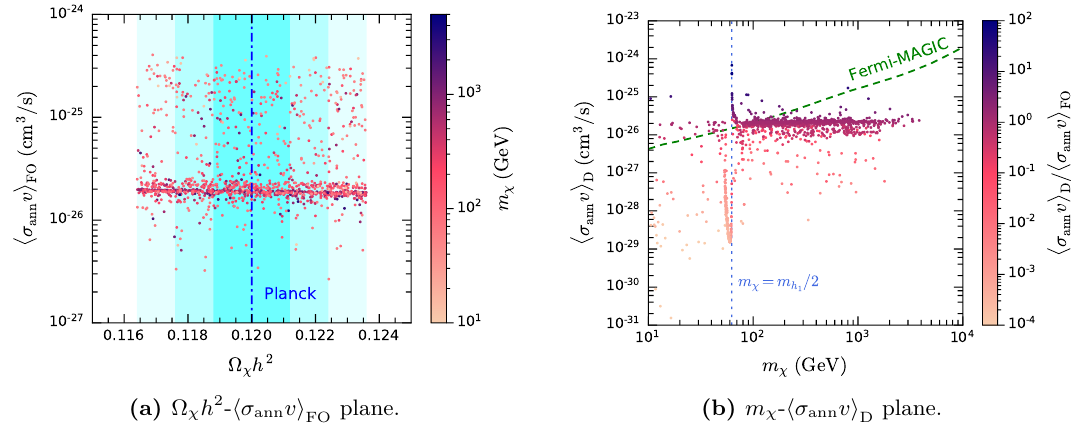
(a) and m - h σ χ ann v i D FO and h σ , respectively. The blue χ ann v i D / h σ ann v i FO 2 = 0 . 1200 ± 0 . 0012 [60]. In the right DM h = m 2 . χ h 1 /